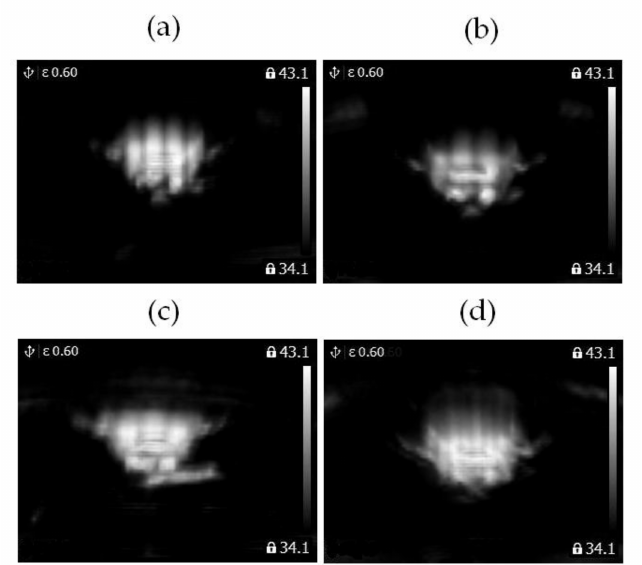
Figure 15. ( a ) Image of arithmetic mean of thermal images of the healthy BLDC motor at 1450 rpm ( class 1 ). ( b ) Image of arithmetic mean of thermal images of the healthy BLDC motor at 2100 rpm ( class 2 ). ( c ) Image of arithmetic mean of thermal images of the blocked ventilation of the BLDC motor at 1450 rpm ( class 3 ). ( d ) Image of arithmetic mean of thermal images of the blocked ventilation of the BLDC motor at 2100 rpm ( class 4 ). The computed differences diff 1 , . . . , diff 6 are shown in Figure 16.